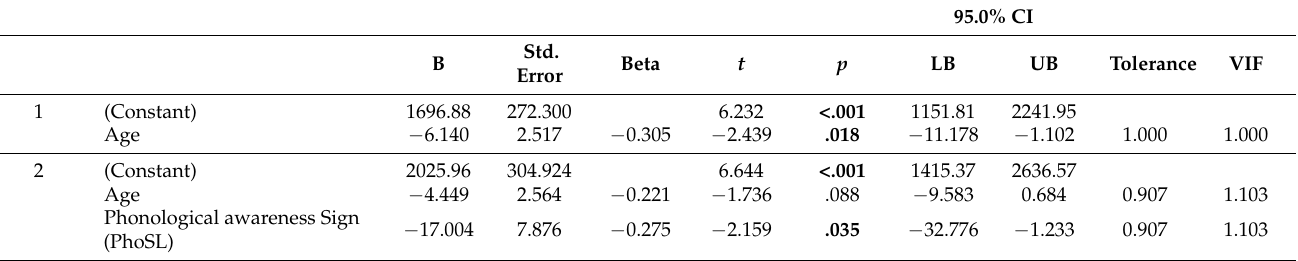
Table 7. Regression coefficients for word RTs at T3. Significant predictors are bolded.